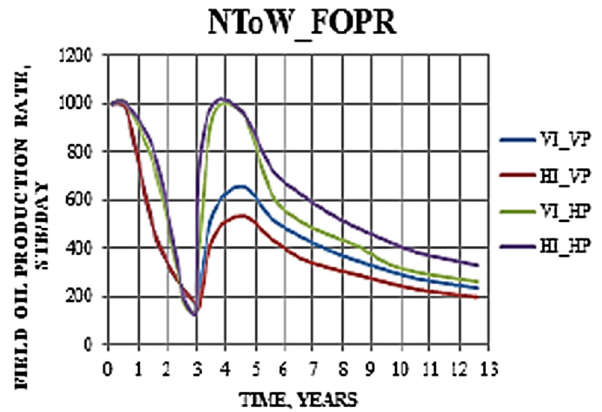
Fig. 23 Plot of the field water-cut with time for different NToW scenarios